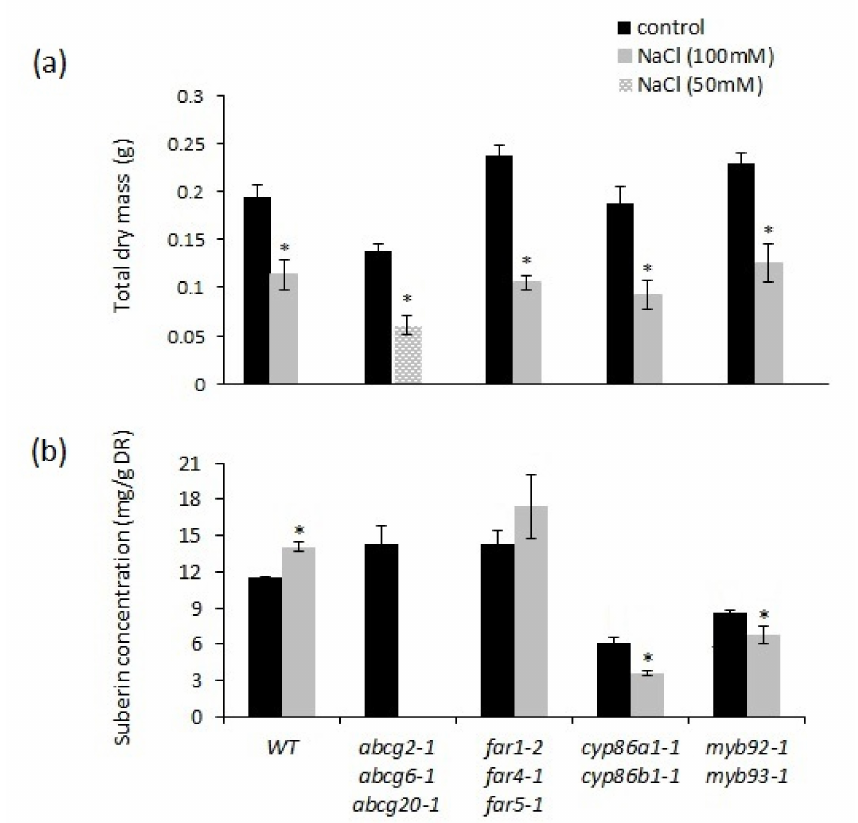
Figure 8. Comparison of total dry mass and total suberin content in wild-type and suberin mutants under control and after treatment with 50 mM or 100 mM NaCl for 2 weeks. Wild-type, far1- 2 far4-1 far5-1 , cyp86a1-1 cyp86b1-1 , and myb92-1 myb93-1 plants were exposed to 100 mM NaCl and abcg2-1 abcg6-1 abcg20-1 was exposed to 50 mM NaCl. ( a ) Total dry mass; ( b ) total poly-aliphatic suberin. Abcg2-1 abcg6-1 abcg20-1 NaCl treatment data are not included in Figure ( b ), as sufficient root biomass was not present at harvesting. Abcg2-1 abcg6-1 abcg20-1 mutant was also excluded from the statistical analysis. Mean values in dry mass are given in grams from ten replicate samples ± SE. Each replicate consisted of one individual plant. Mean values of suberin contents are given in milligrams of suberin per gram of delipidated dry residue (DR) from 3–4 replicate samples ± SE. Each replicate consisted of roots from 4–5 separate plants. ANOVA results indicated significant interactions between genotype and treatment effects in root suberin data at p < 0.01 (Table S2). Asterisks indicate significant differences by Student’s t -test at p < 0.05 comparing control and NaCl